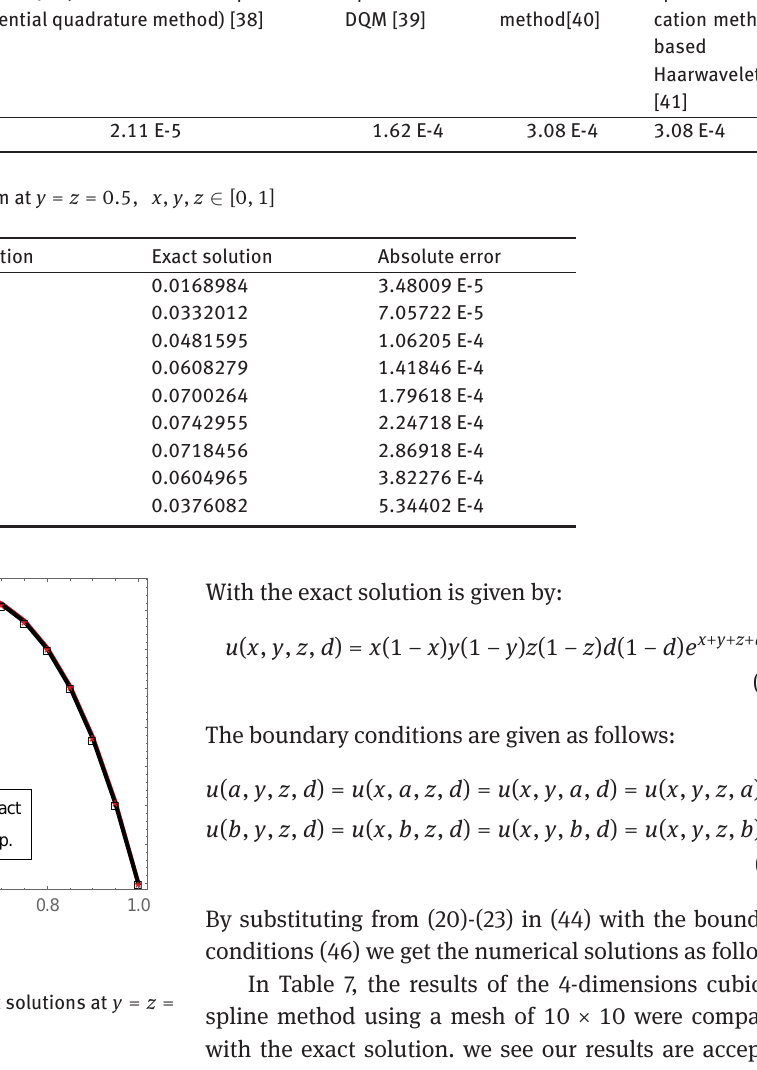
Table 5: Maximum absolute error according to the method used for third problem. The proposed method